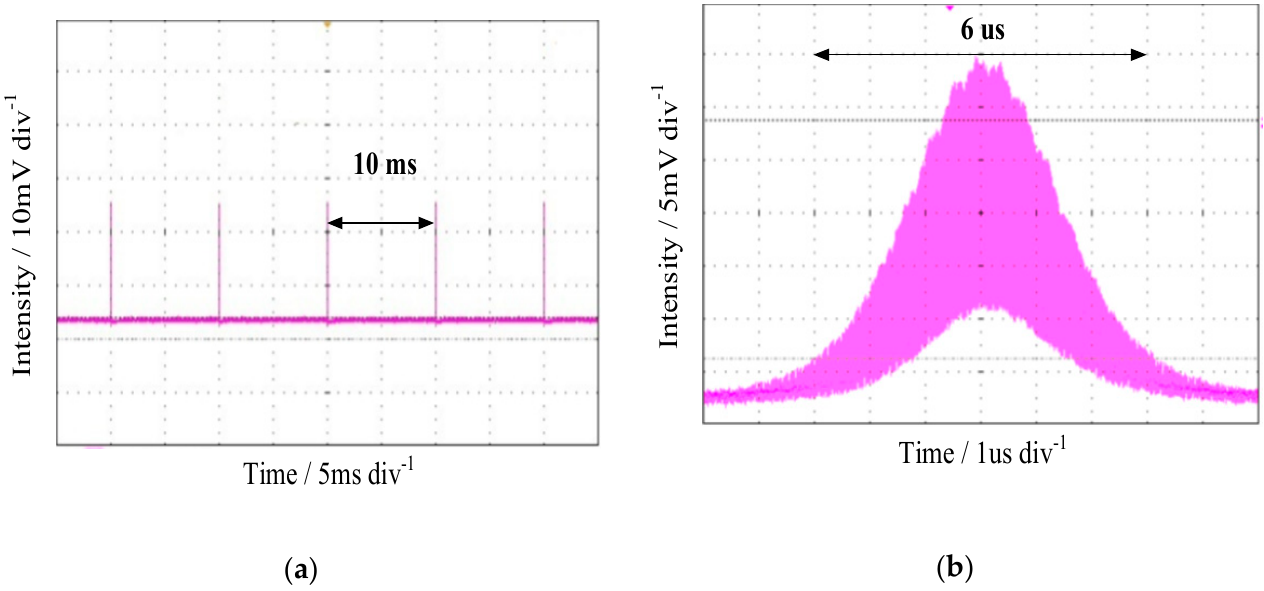
Figure 4. Pulse waveform of the QML Er 3+ − doped fiber laser: ( a ) pulse sequence of Q − switched; ( b ) envelope of single Q- switched giant pulse.